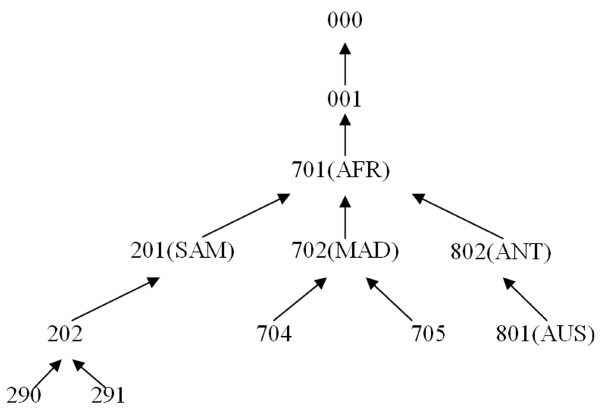
Fig. 23. An illustration of a reconstruction tree showing the rela- tive rotation hierarchy of different tectonic plates to each other at a time instance in the past (AFR: Africa; ANT: Antarctica; AUS: Australia; MAD: Madagascar; SAM: South